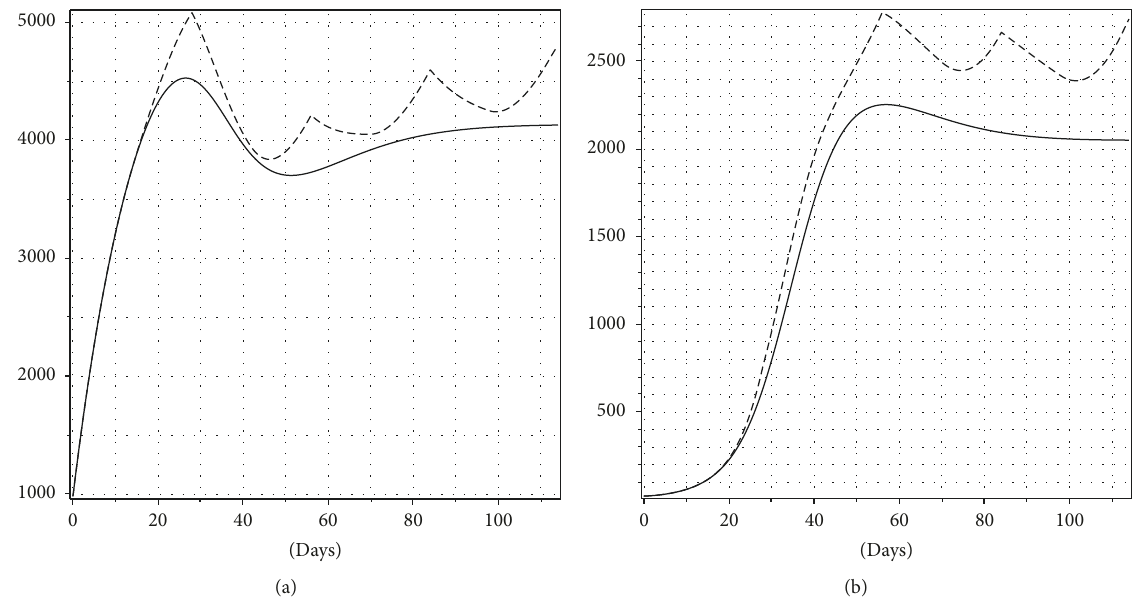
Figure 9: Susceptible (a) and infected (b) mosquito dynamics with constant (solid curve) and biweekly (dash curve) strategy.